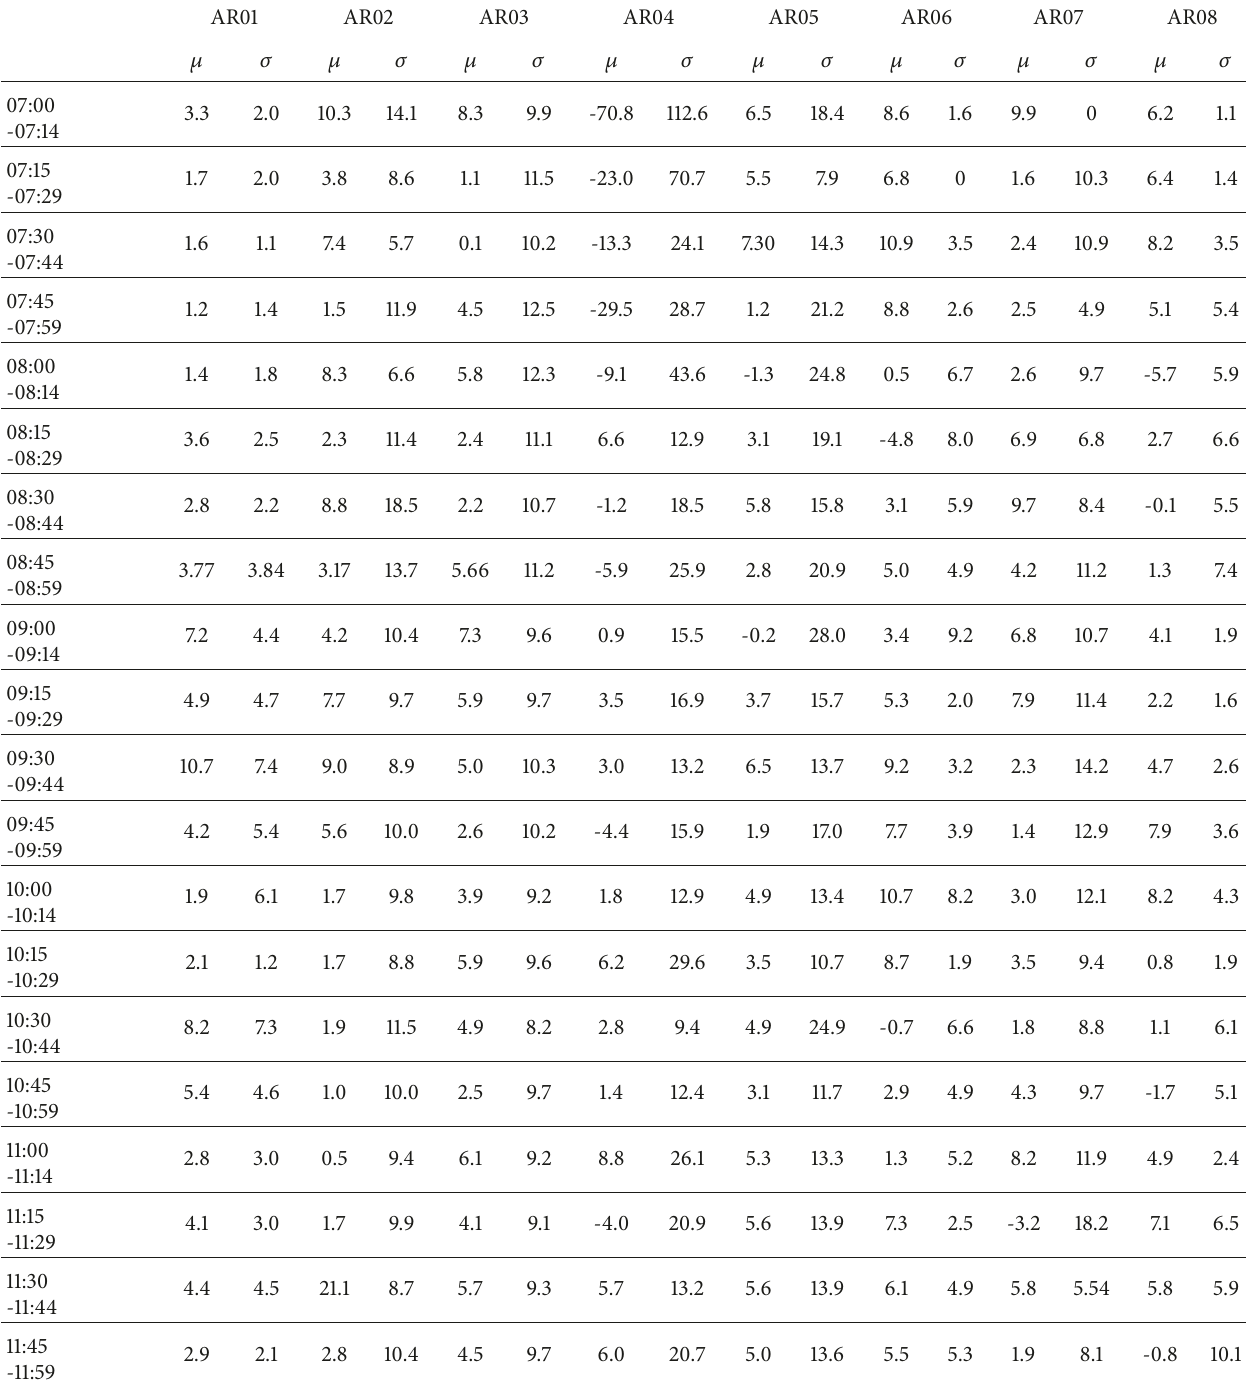
Table 2: Mean 𝜇 and variance 𝜎 of aircraft’s predicted time error Δ𝑡 𝑜𝑢𝑡 𝑖 of leaving sector AR01-AR08